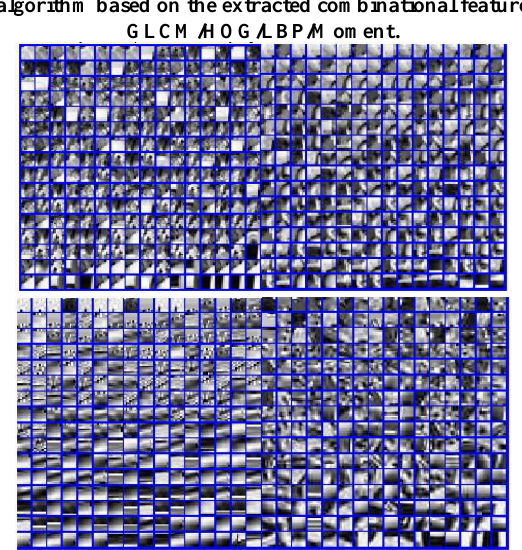
Figure 7. The learned dictionary by the proposed detection algorithm (MIT database) using GLCM/HOG/LBP/Moment feature vector: First row for face, and second row for non-face training